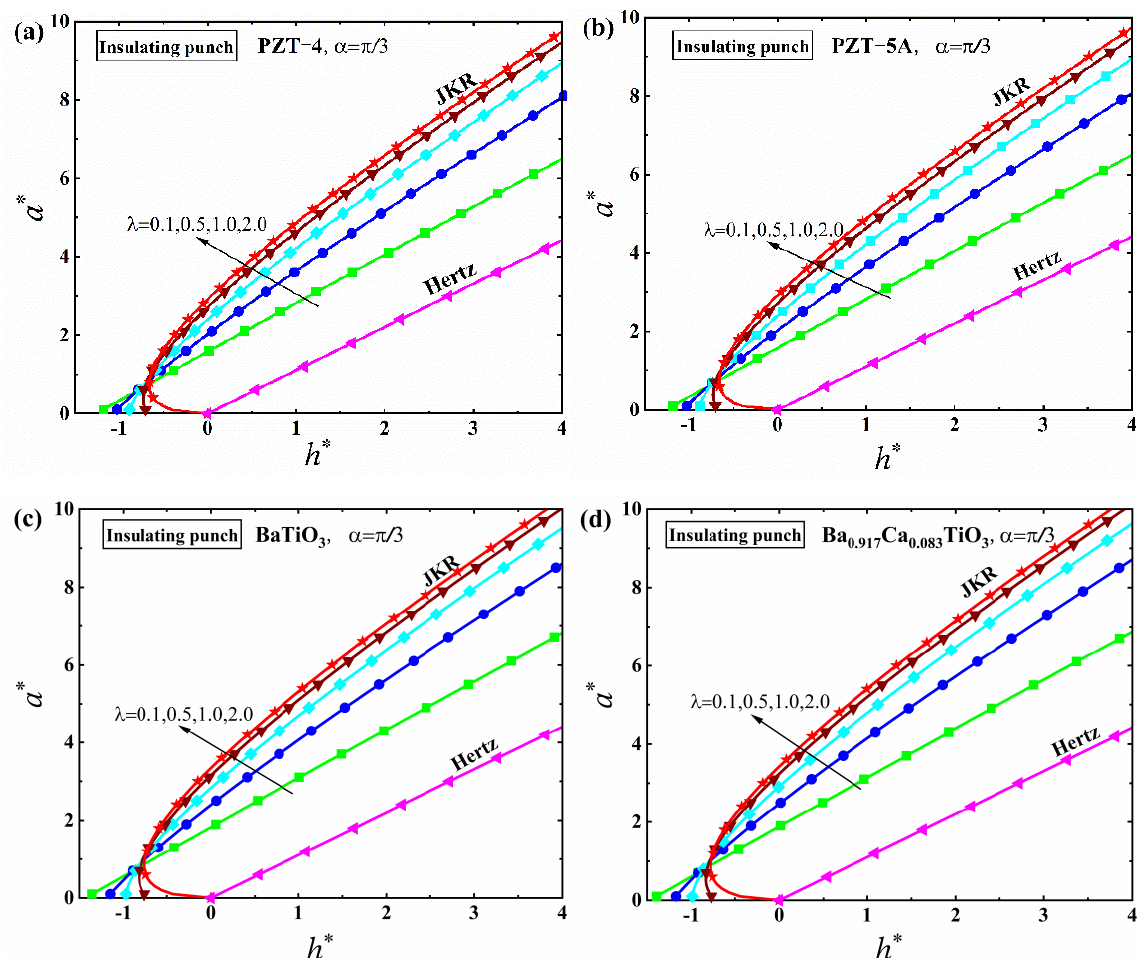
Figure 19. The dimensionless contact radius, a ∗ , as a function of the dimensionless indentation depth, h ∗ , under the action of an insulating punch for the M-D model. ( a ) PZT-4. ( b ) PZT-5A. ( c ) BaTiO 3 . ( d ) Ba 0.917 Ca 0.083 TiO 3 .